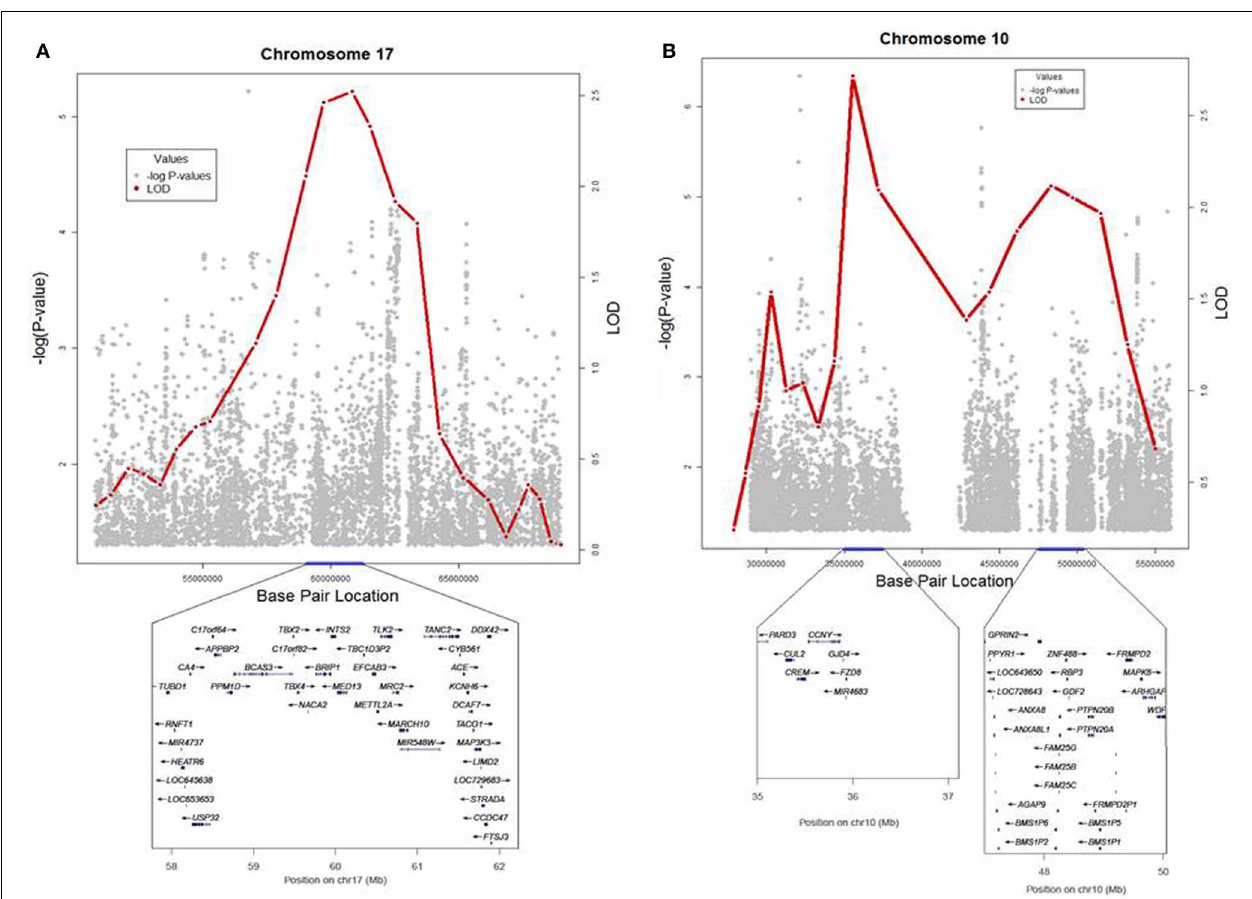
FIGURE 3 | (A,B) Locus plots for the results from linkage and association analyses in 17q23.2 and 10q11.21. LOD scores and − log 10 ( p -value) are presented for the 2 loci.